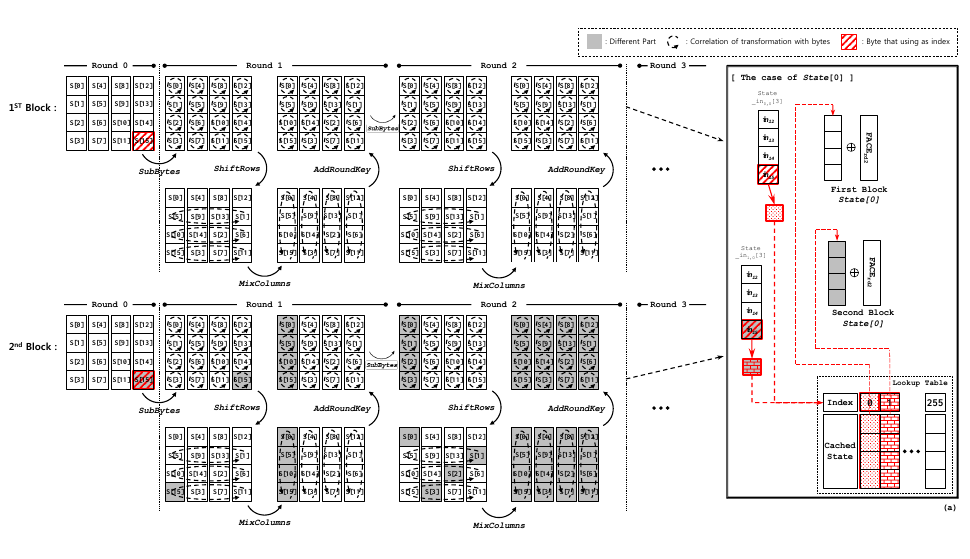
Figure 7: FACE rd 2+ : The process of AES round 1, round 2, and FACE rd 2+ . (a) shows how to refer the pre-computation values and how to calculate the result of round